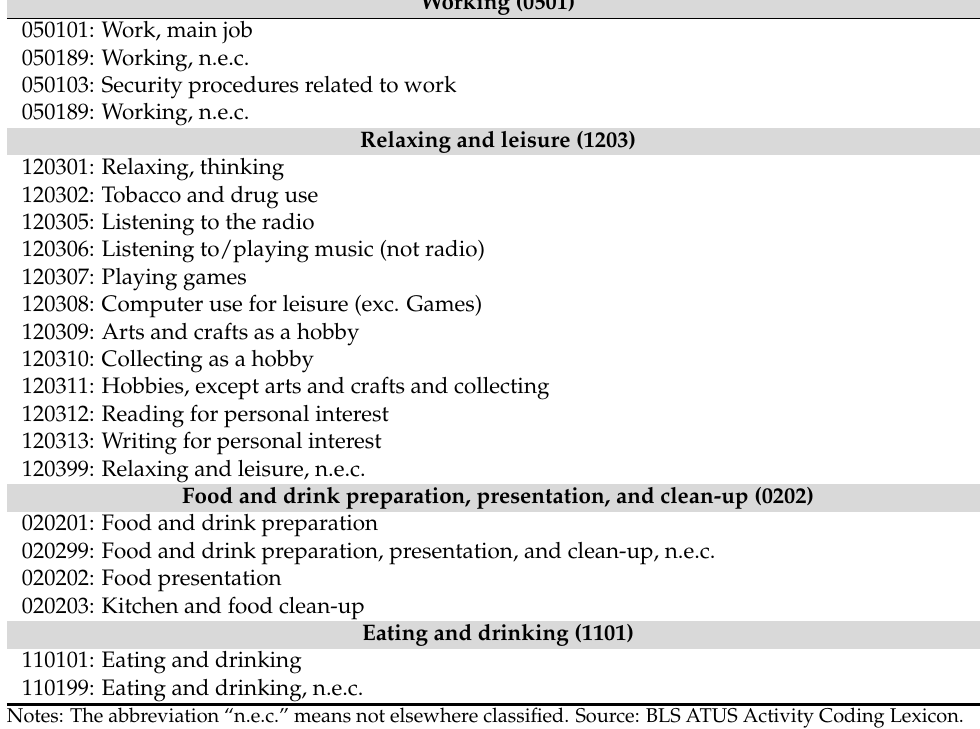
Table A1. Activity codes used in the analysis.